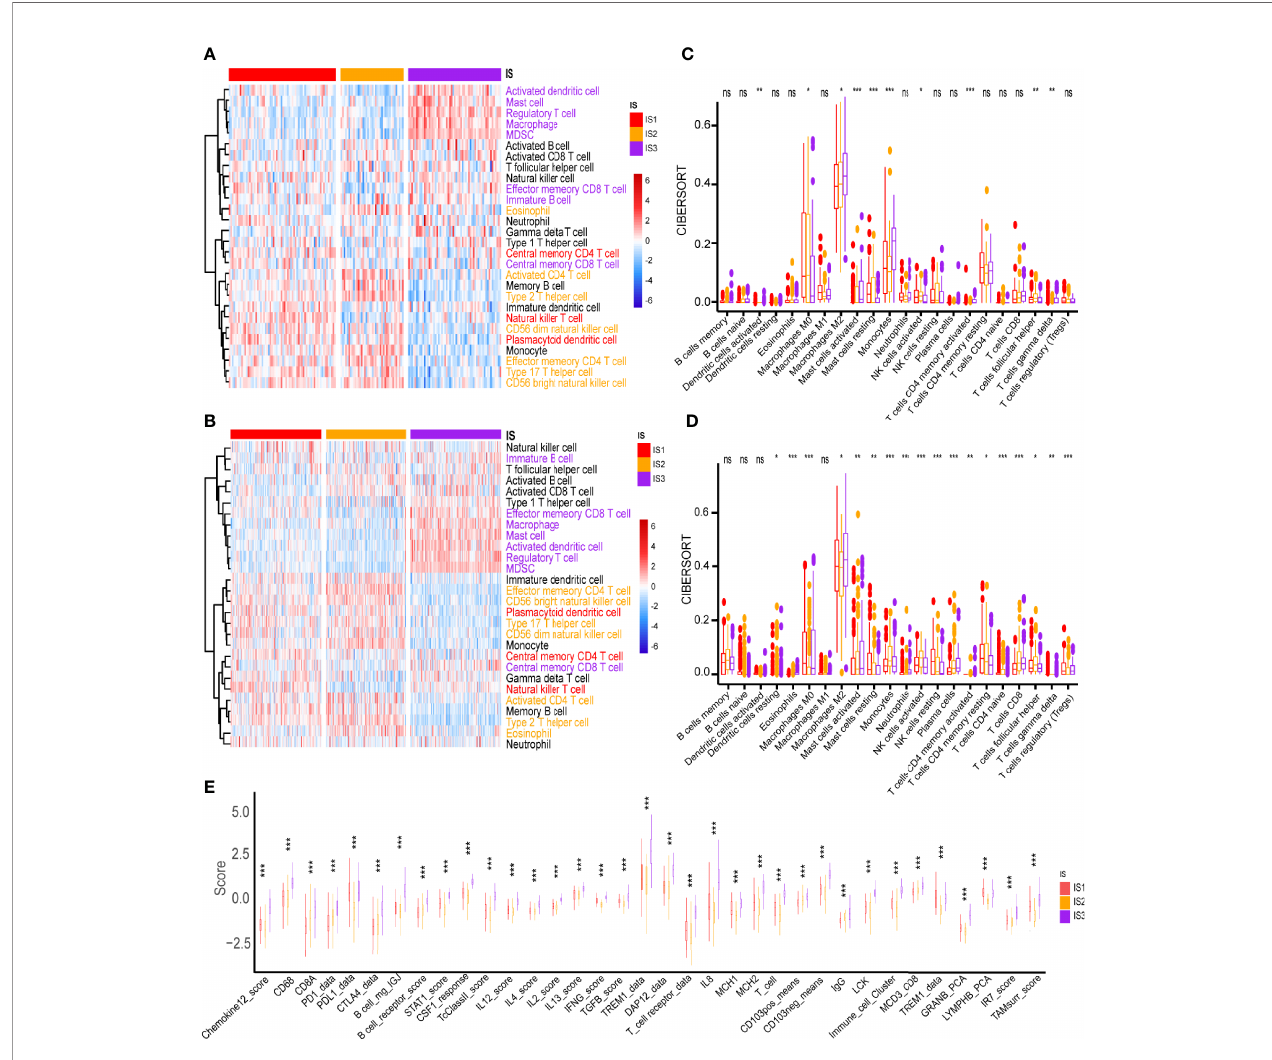
FIGURE 5 | Cellular and molecular characteristics of immune subtypes. Differential enrichment scores of 28 immune cell signatures among GBM immune subtypes in (A) TCGA and (B) CGGA cohorts. Different colors of the text on the right represents the immune cells were more enriched in the corresponding subtypes. Differential enrichment scores of CIBERSORT 22 immune cell signatures in (C) TCGA and (D) CGGA cohorts. (E) Differential enrichment scores of 56 immune signatures among GBM immune subtypes. * p < 0.05, ** p < 0.01, *** p < 0.001. ns, no signi fi